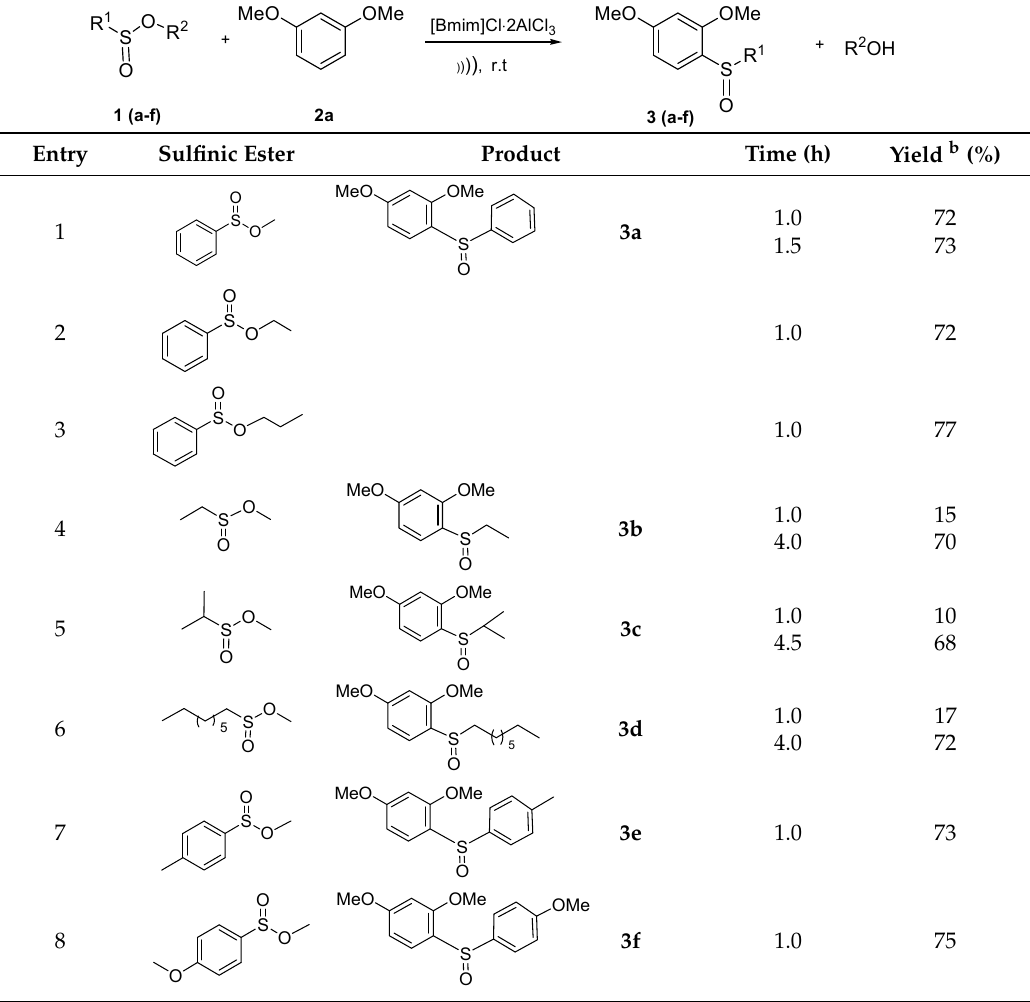
Entry Sulfinic Ester Product Entry